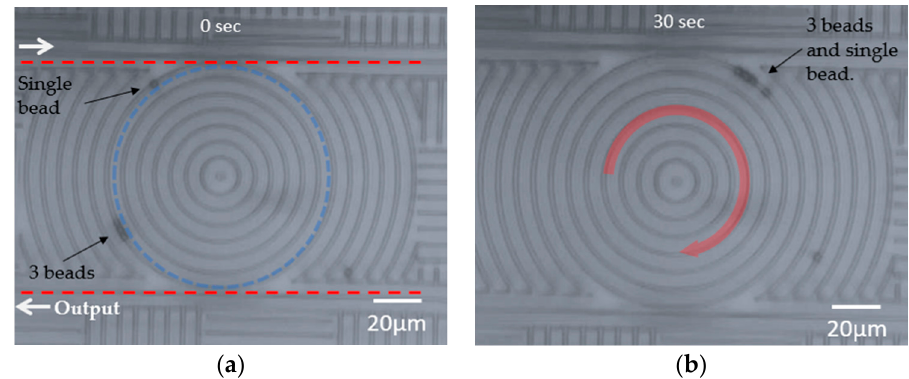
Figure 6. Four particles trapped on top of the ring waveguide in two groups traveling at different speeds. ( a ) Initially, they were separated by approximately one quarter of the ring circumference, with the group of three beads traveling at a higher speed. ( b ) The group of three beads caught up with the single bead after 30 s.